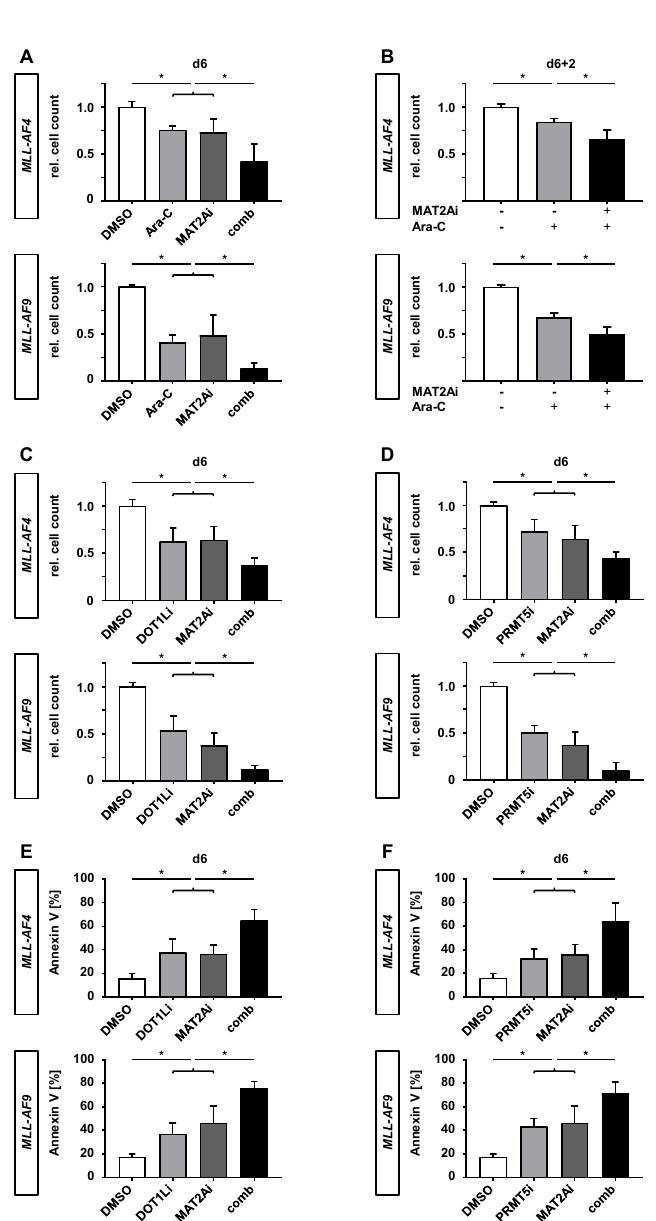
Figure 6. PF-9366 sensitizes MLL r cells to chemotherapy and acts synergistically in combination with targeted therapies. ( A ) MLL-AF4 / -AF9 cells were treated with 10 nM cytarabine (Ara-C) and 10 µ M PF-9366 (MAT2Ai) simultaneously for 6 days. Single treatments or vehicle (DMSO) were used as controls, respectively. Experiment was performed in three biological replicates ( n = 3) and technical triplicates. ( B ) Initial treatment with PF-9366 (MAT2Ai + ) or vehicle (MAT2Ai − , DMSO) for 6 days was washed out and cells were reseeded with 10 nM cytarabine (Ara-C + ) or vehicle (Ara-C − , PBS) and monitored for 2 days (6 + 2). Experiment was performed in three biological replicates ( n = 3) and technical triplicates. Relative cell count was determined by flow cytometry using counting beads. ( C , D ) MLL-AF4 / -AF9 cells were treated with either 1 µ M EPZ004777 (DOT1Li), 1 µ M EPZ015666 (PRMT5i), or 10 µ M PF-9366 (MAT2Ai), in respective combinations or vehicle (DMSO) for 6 days. Relative cell count was analyzed by flow cytometry using counting beads. Pooled data of three biological replicates ( n = 3) performed in technical triplicates are shown. ( E , F ) Annexin V staining revealed apoptotic cells in MLL-AF4 / -AF9 cells treated with the indicated compounds for 6 days. Experiment was performed in three biological replicates ( n = 3) and technical triplicates. Data were acquired using flow cytometry. Bars represent the mean. Error bars indicate SD. One-way ANOVA was used with Sidak correction: *, p <